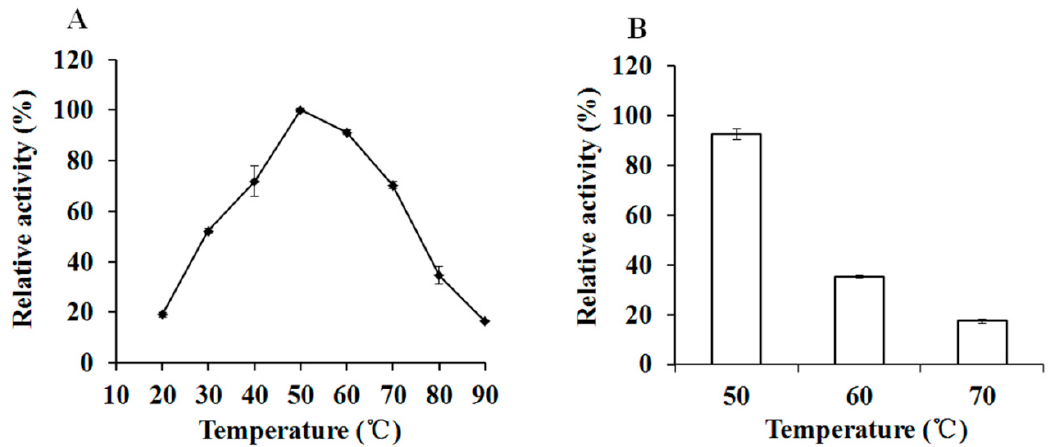
Figure 5. Effect of temperature on the optiXynB activity ( A ) and its temperature stability ( B ). The maximum value was set as 100 %.